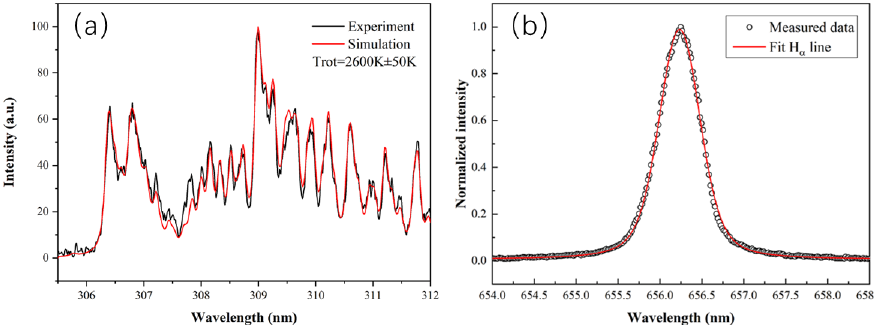
Figure 4. ( a ) OES of the plasma scalpel from 305.5 – 312 nm. The simulation of spectra by LIFBASE is also shown. ( b ) Voigt fitting of Hα line measured in the plasma. The fitting FWHM of Stark broadening is 0.208 nm, and the calculated electron density is 7.1 × 10 15 cm − 3 . Reproduced with permission from Ref. [8]. Copyright (2020) IOP Publishing, Ltd.